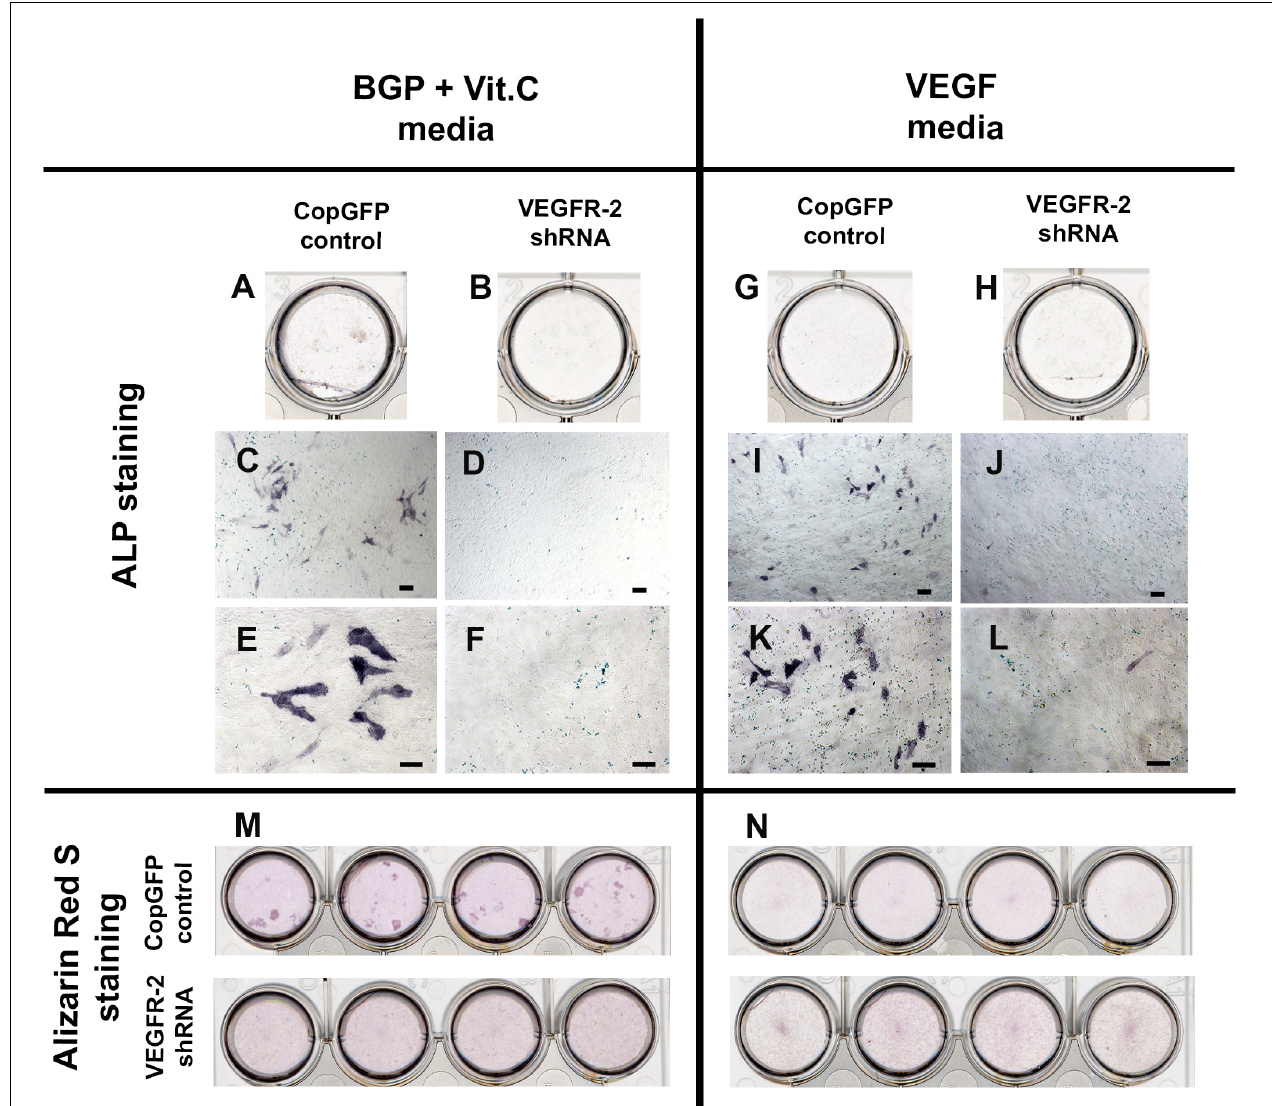
FIGURE 5 | Alkaline phosphatase and Alizarin Red S staining in CopGFP control and VEGFR-2 shRNA DPSCs after a culture in BGP + Vit. C media and VEGF media. After induction in BGP plus vitamin C, some differentiated CopGFP DPSCs (A,C,E) but not VEGFR-2 shRNA DPSCs (B,D,F) demonstrated positive staining of alkaline phosphatase. Alizarin Red S staining showed some positive mineralized nodules in CopGFP DPSCs but not VEGFR-2 shRNA DPSCs (M) . For VEGF induction, a similar results of alkaline phosphatase staining were observed in both CopGFP control (G,I,K) and VEGFR-2 shRNA DPSCs (H,J,L) , compared to the BGP plus vitamin C. Interestingly, no mineralized nodule was found in both cell groups after VEGF induction (N) . Scale bars indicate 100 µ